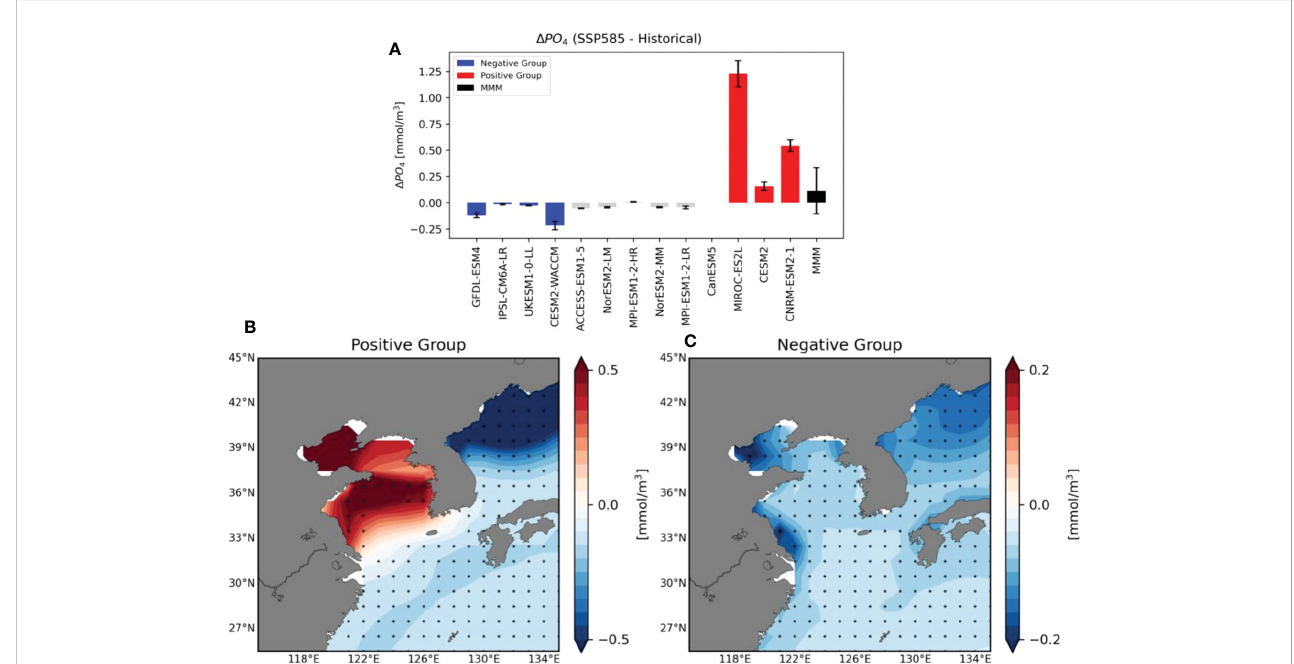
FIGURE 2 (A) Area-averaged future changes in surface (upper 30 m depth mean) Dissolved Inorganic Phosphorus (DIP) concentrations in the YECS region using 12 CMIP6 models (excluding the CanESM5 Model). The black bar represents MMM of 12 models of future change in the DIP concentrations and the crosses indicate signi fi cance at the 95% con fi dence level. The order of the graph is aligned the same as that of the future change of the SCHL concentration. (B, C) Spatial distribution of differences in the ensemble mean DIP concentrations of historical and future climate periods for the positive and negative Groups, respectively. Black dots indicate points at which the differences are signi fi cant at the 95% con fi dence level using the bootstrap method.